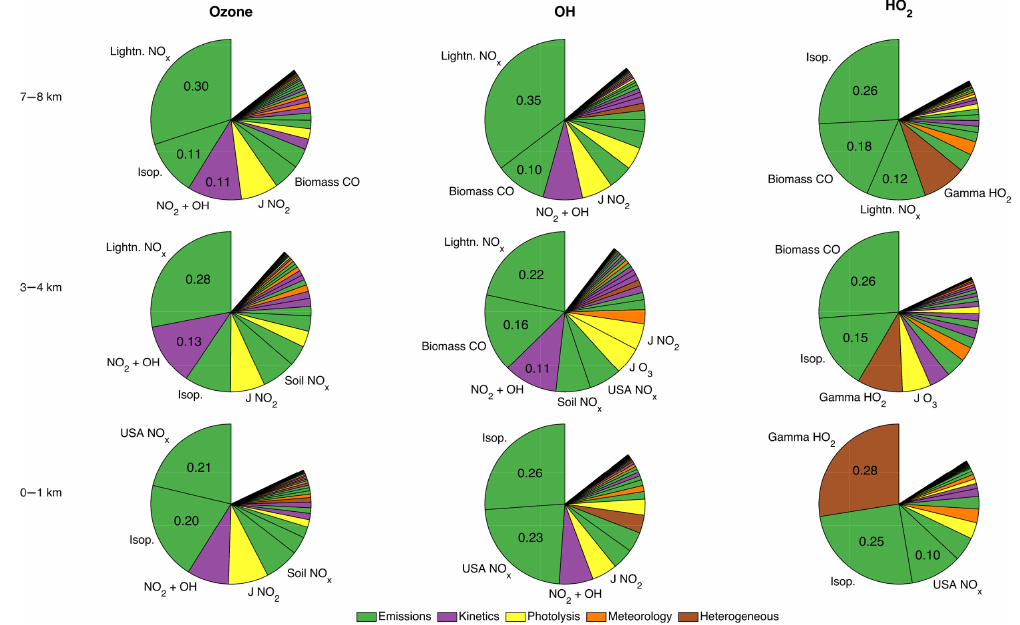
Figure 6. First-order sensitivity indices for median flight track ozone, OH, and HO 2 for INTEX-A flights. Legend categories are defined in Table 1. Sensitivity indices are labeled in pie slices for factors for which S i ≥ 0 .